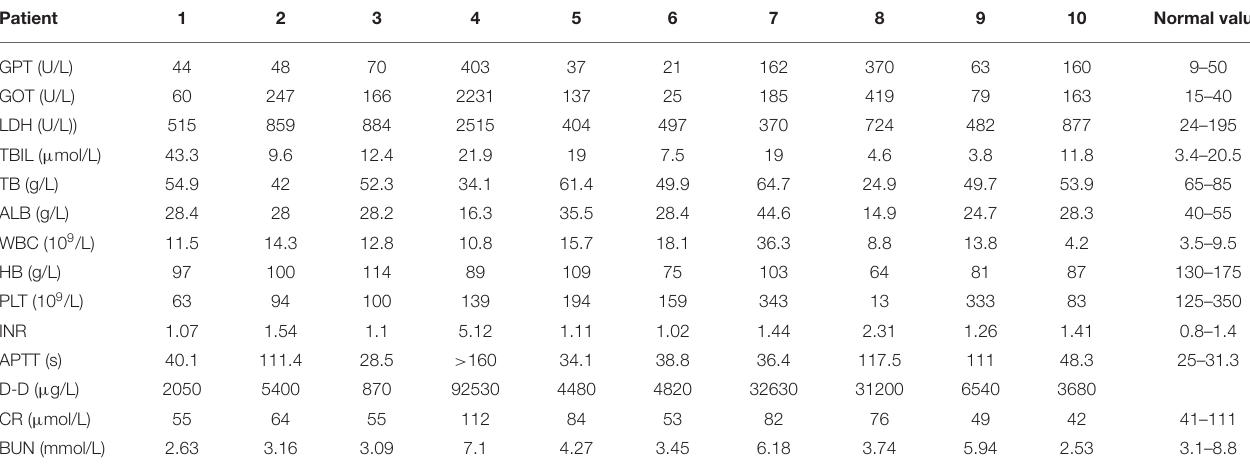
TABLE 3 | Laboratory tests at the time of ECMO initiation.